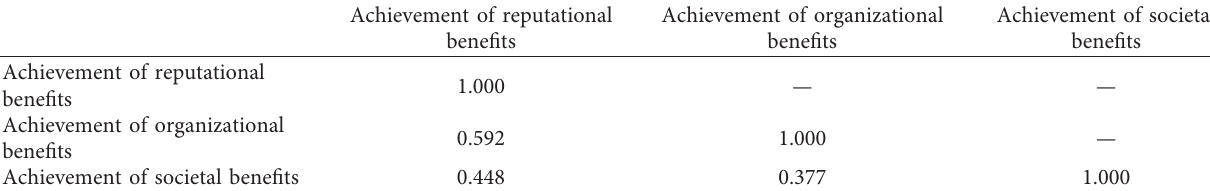
Table 6: Correlations among the three